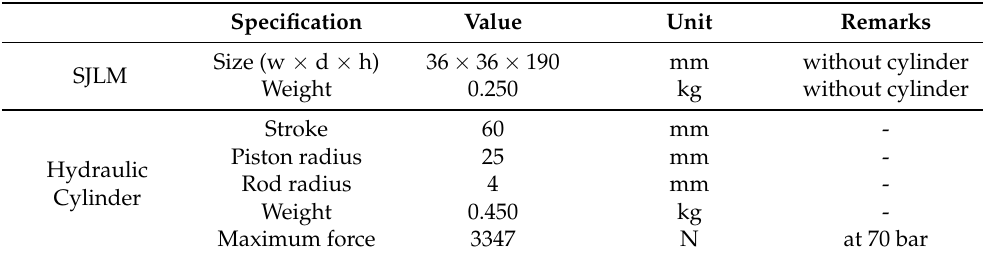
Table 1. The specification of the SJLM and its hydraulic